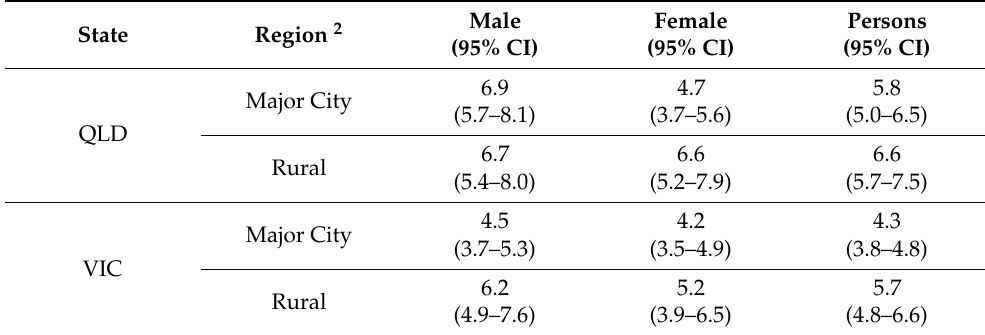
Table 5. UM ASR 1 in QLD and VIC rural and major city areas from 2001 to